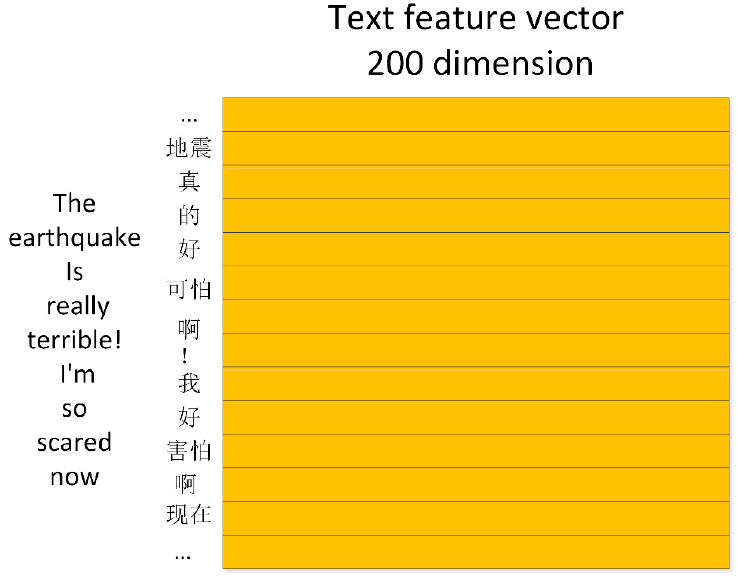
Figure 3. Structure of the text feature vector.